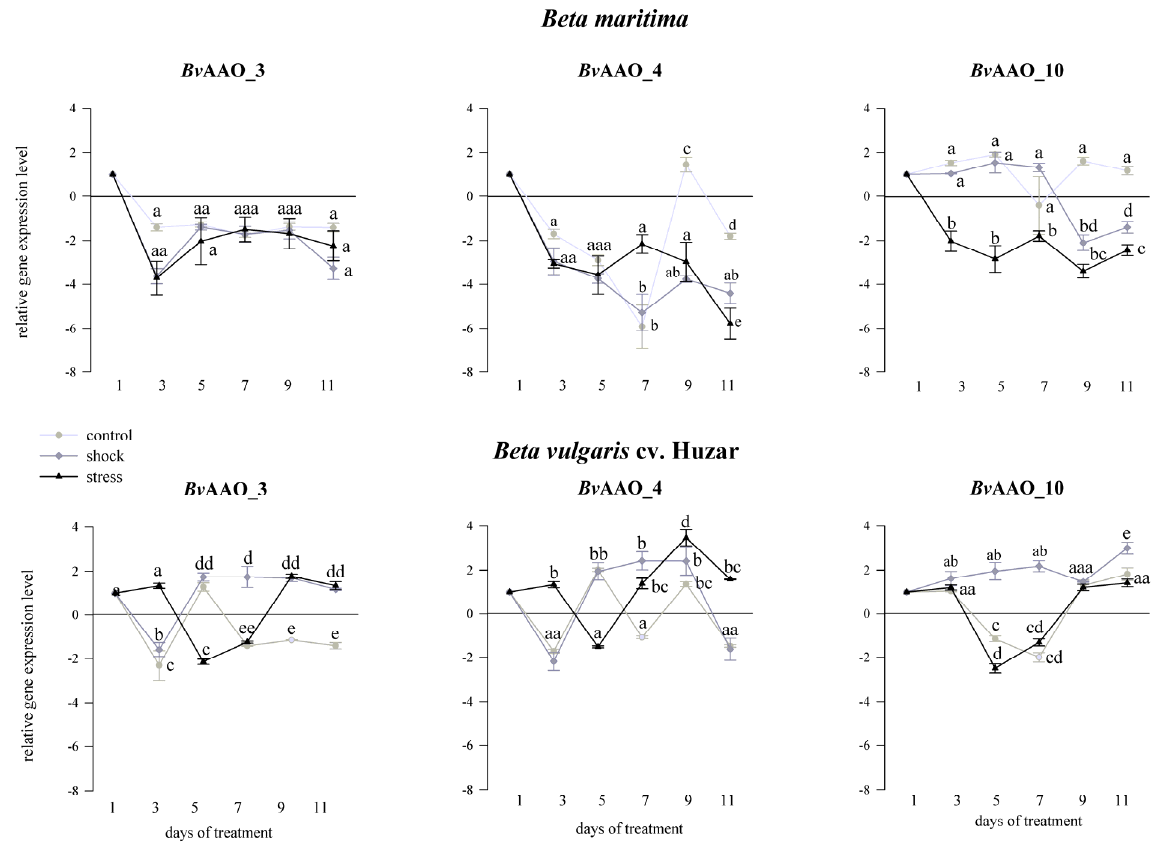
Figure 4. Expression profiles of AAO genes Bv AAO_3, Bv AAO_4 and Bv AAO_10 determined in leaves of Beta vulgaris ssp. maritima and Beta vulgaris cv. Huzar subjected to salt shock or stress. Control − light gray lines, salt shock − gray lines, salt stress − dark gray lines. Different letters denote significant differences at p < 0.01 (ANOVA followed by Tukey’s test). “Whiskers” indicate standard deviation.